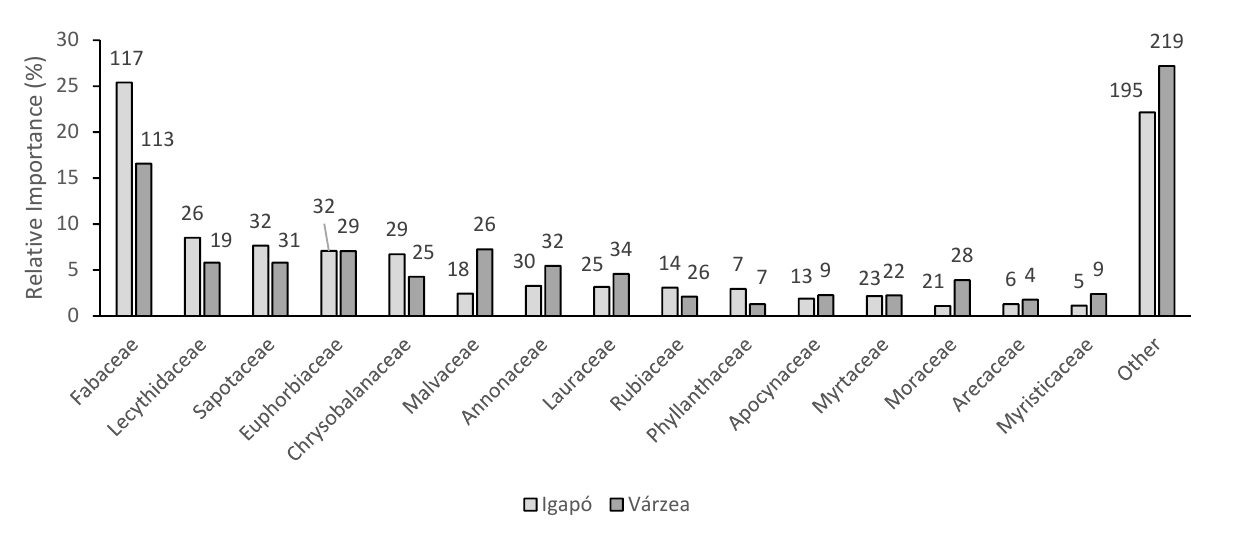
Figure 1. Relative overall importance of the 15 most important tree families in central Amazonian igap ó and v á rzea forests (dbh ≥ 10 cm) based on the floristic inventories presented in Table 1. Numbers above bars represent total species numbers recorded in each